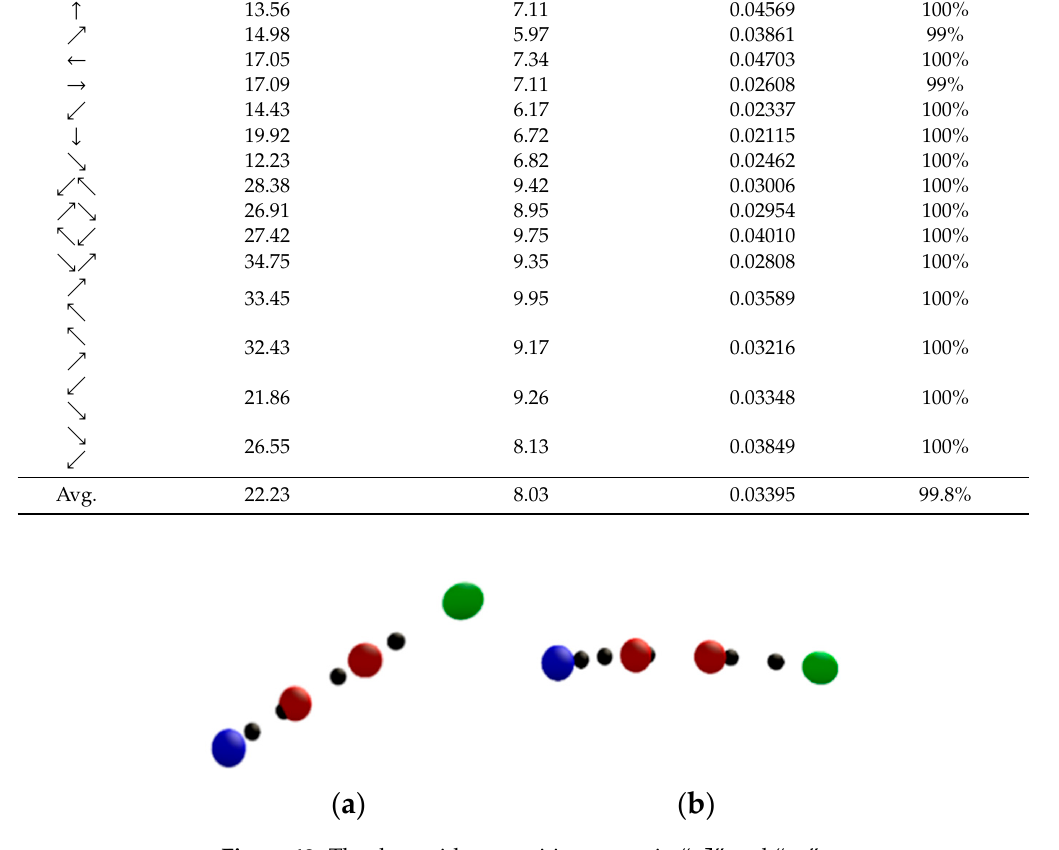
Figure 11. Recognition time for different moving speeds. ( a ) Normal-sampling; ( b ) over-sampling; and ( c ) under-sampling.